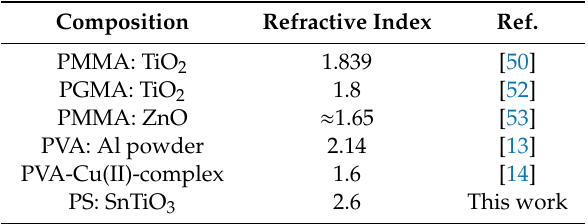
Table 4. Measured refractive index for di ff erent polymer composites.